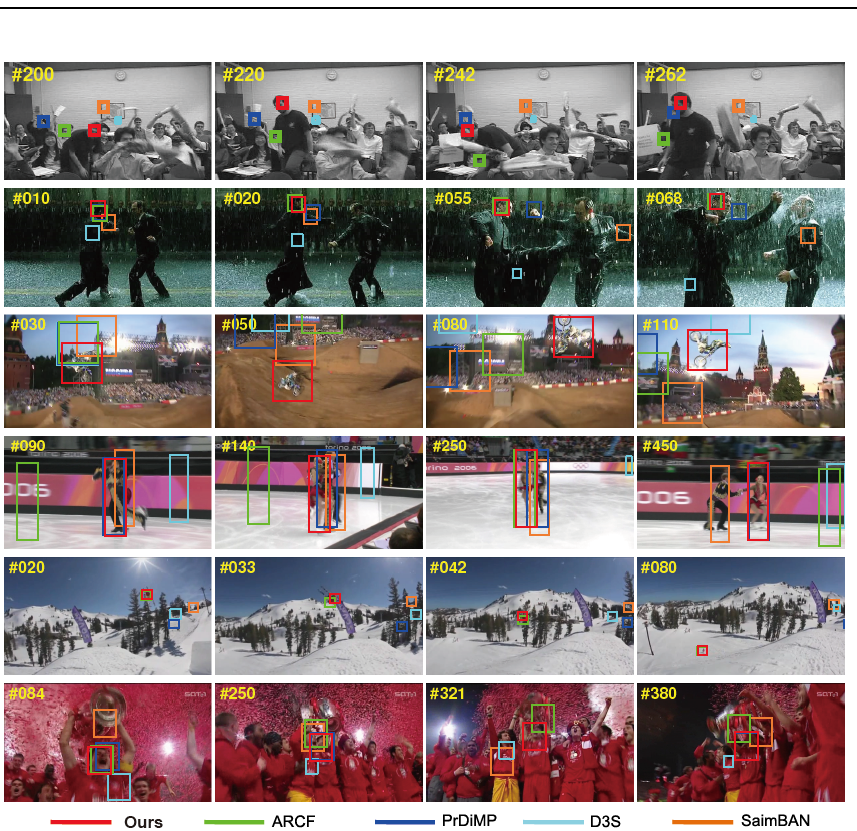
Figure 6. Tacking results on 10 challenging sequences using our algorithm, the ARCF, PriDiMP, D3S and